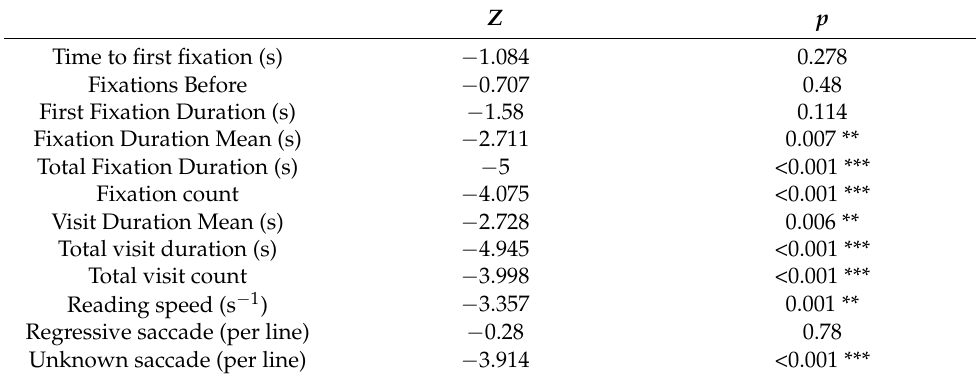
Table 6. Comparison of eye movement between the first and last reading